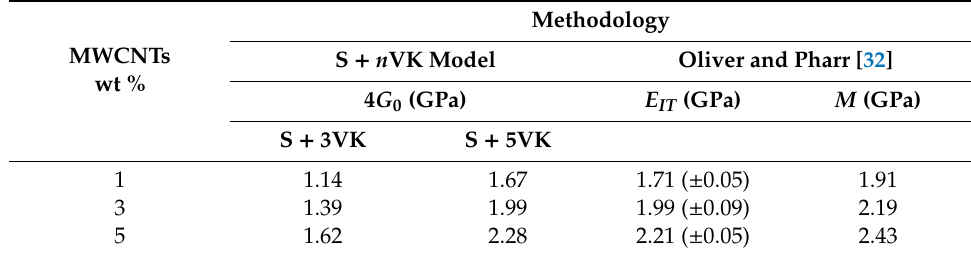
Table 4. Indentation moduli for PP / MWCNT